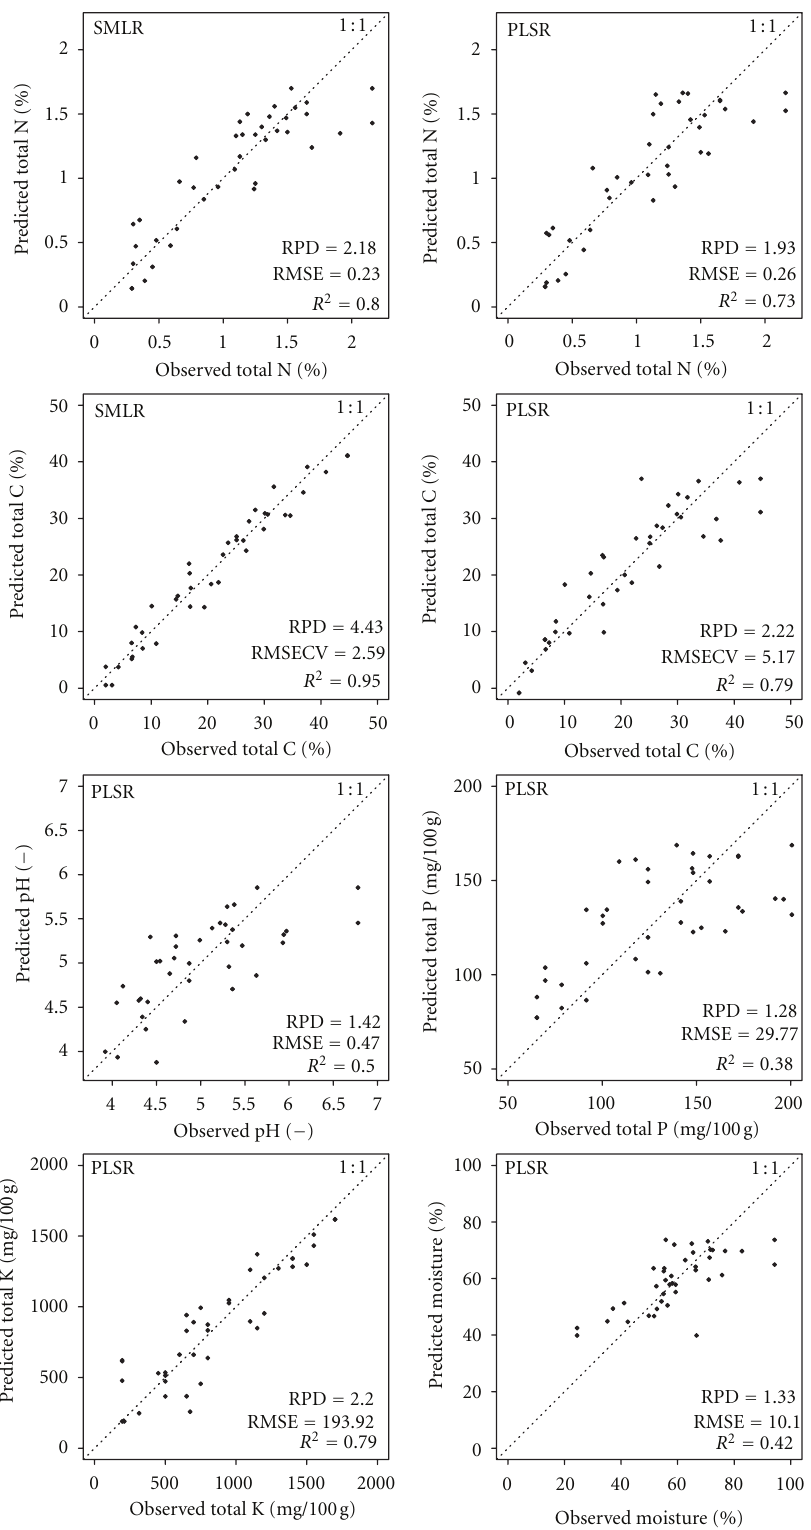
Figure 5: Scatterplots of the observed versus predicted values for multiple soil properties, based on PLSR or SMLR using lab